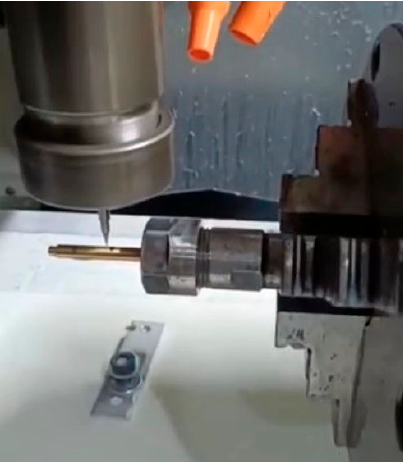
Figure 5. The flow channel on the core body of a variable flow emitter is carved using computerized numerical control technology.